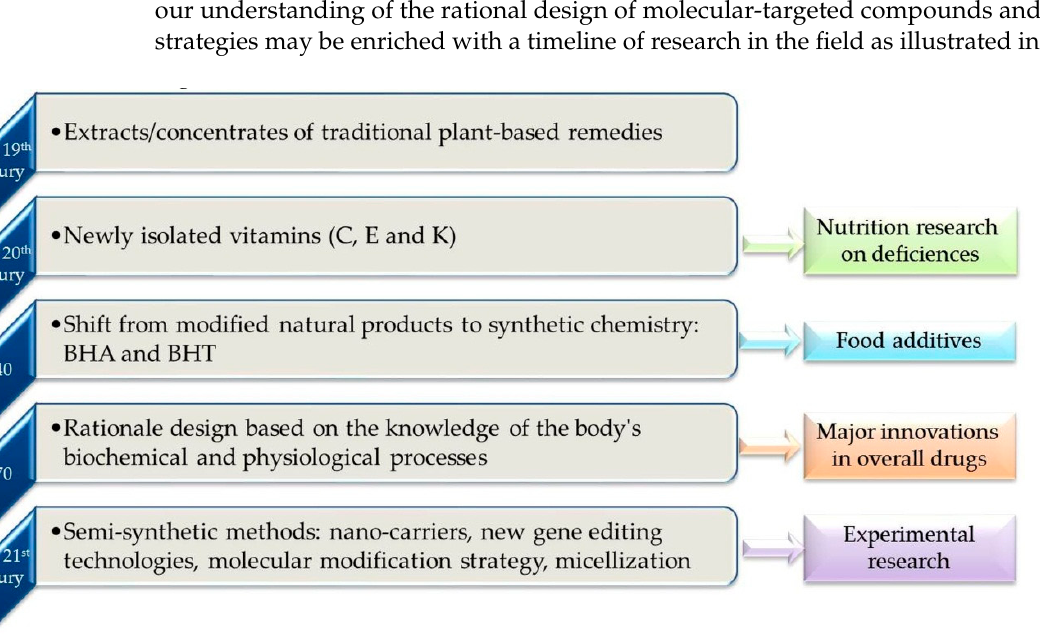
Figure 5. Timeline of important discoveries in the field and ongoing research instruments.